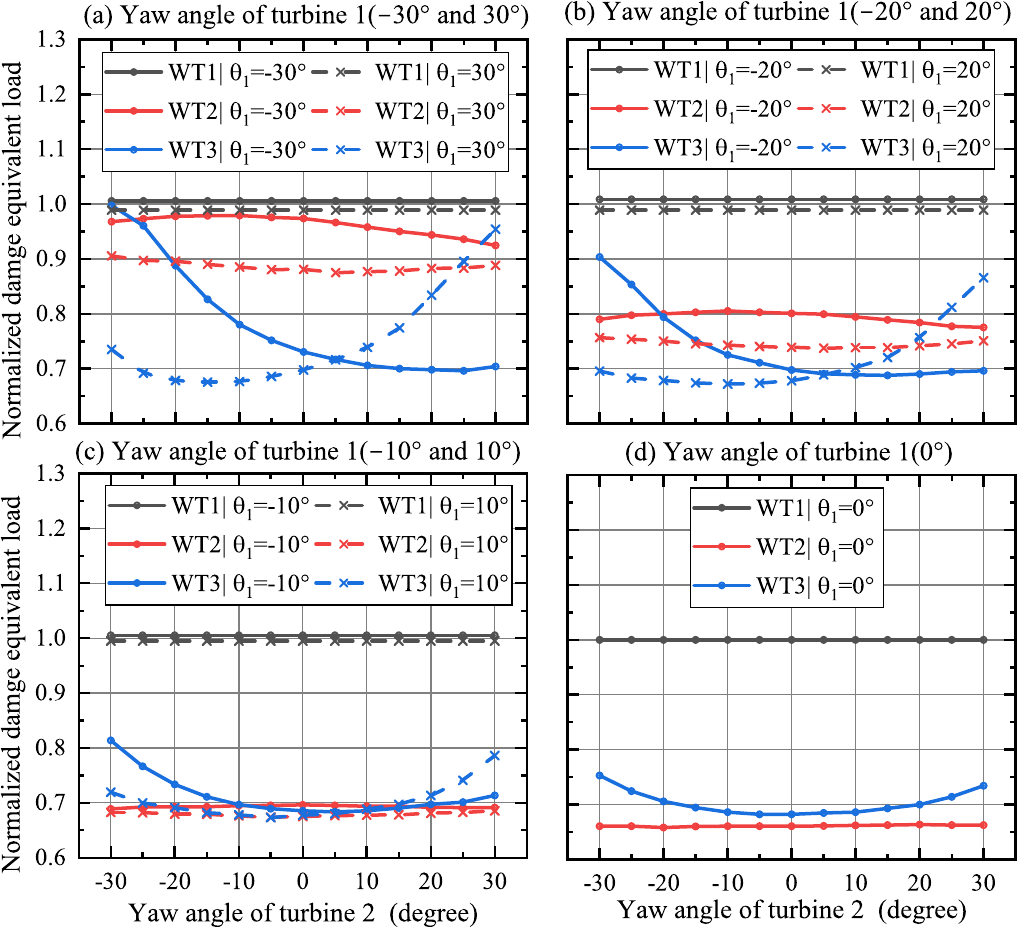
Figure 11. Blade root edgewise moment samples of normalized damage equivalent load under 9 m/s wind speed and 5% turbulence intensity. The damage equivalent load of turbine 1 under zero yaw offset case equals 1. The same axis scale is used in the four